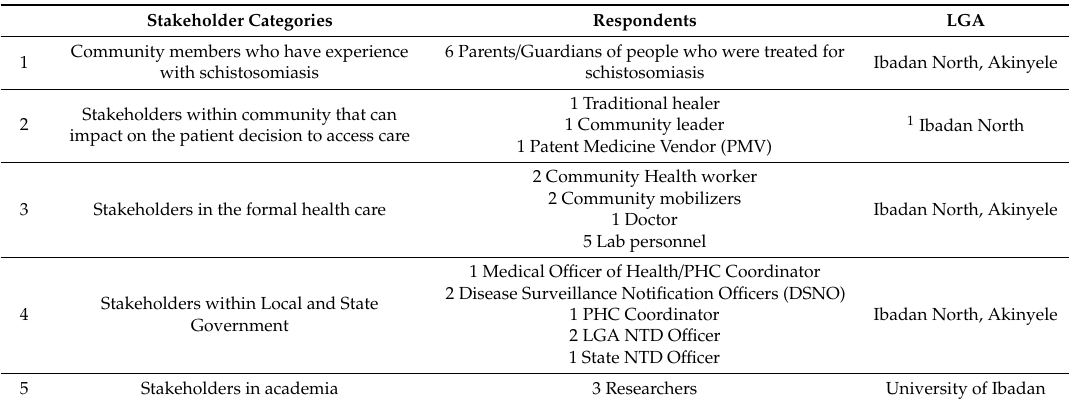
Table 1. Stakeholder categories and